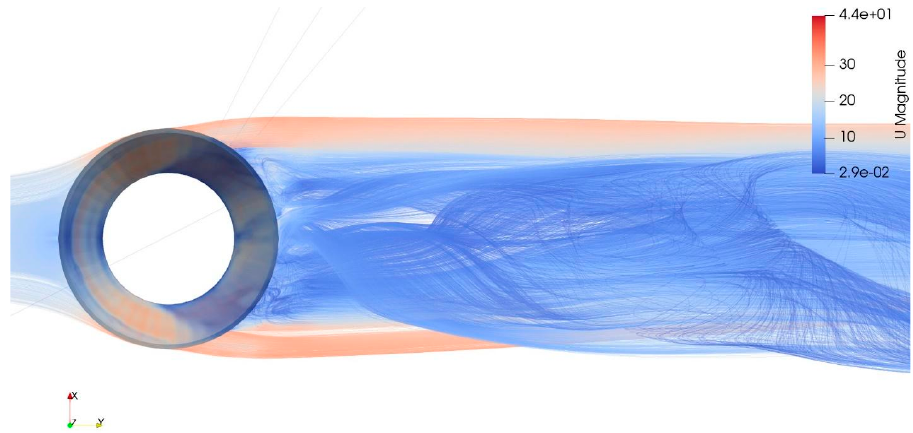
Figure 7. The third and fourth fin channels can be seen at the bottom of the control volume. The Spalart-Allmaras DDES turbulence model colors streams based on their velocity magnitude.